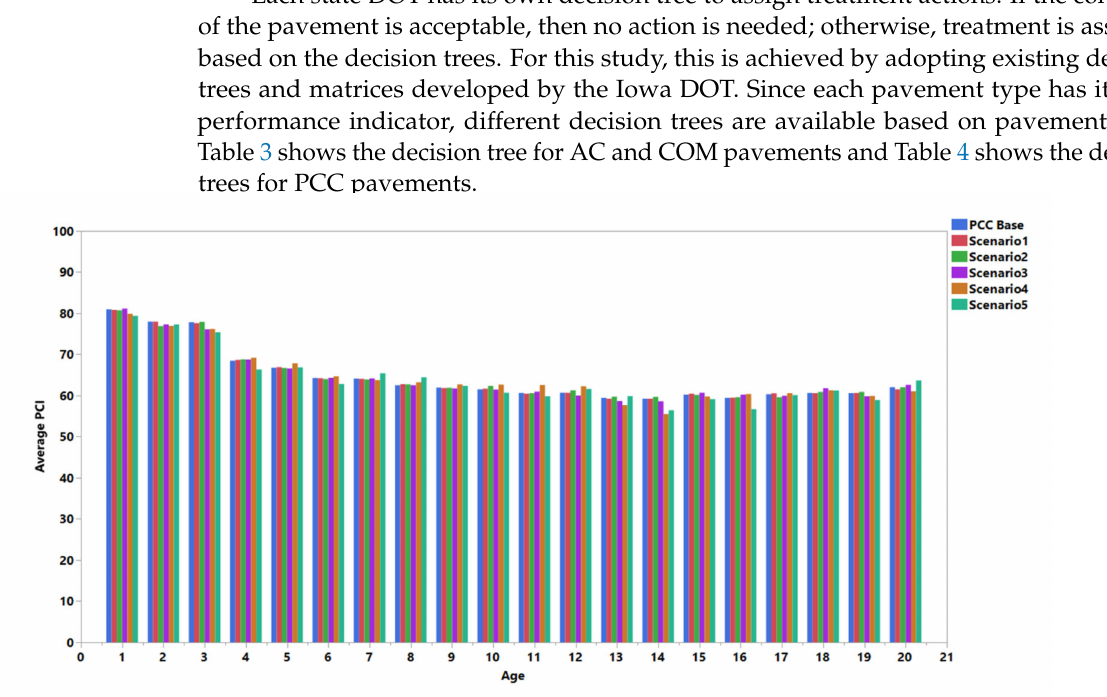
Figure 8. Weighted average PCI for PCC pavements versus pavement